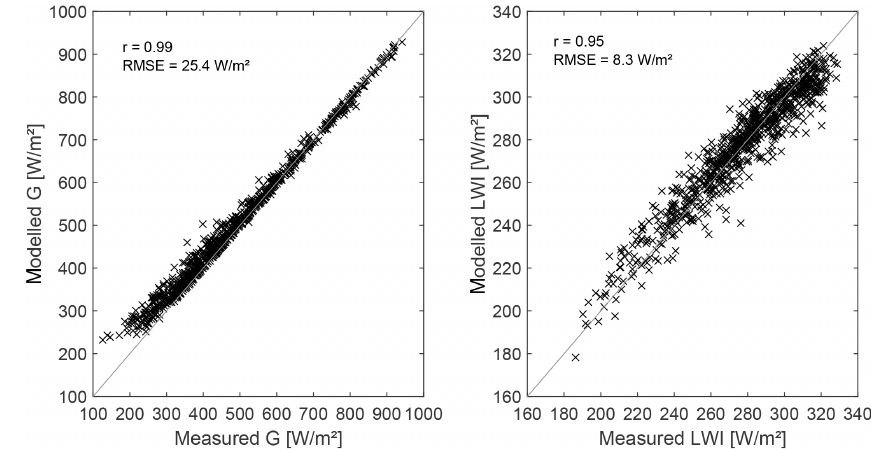
Figure 2. Parameterization performance of downward radiative fluxes for 772 days at the location of the AWS. Scatter plot of mean daily measured versus modelled G (left panel) and LWI (right panel). Hourly values show similar correlation of r = 0.99 (0.93) and RSME = 26.4 (33.8)Wm − 2 for G (LWI), respectively.